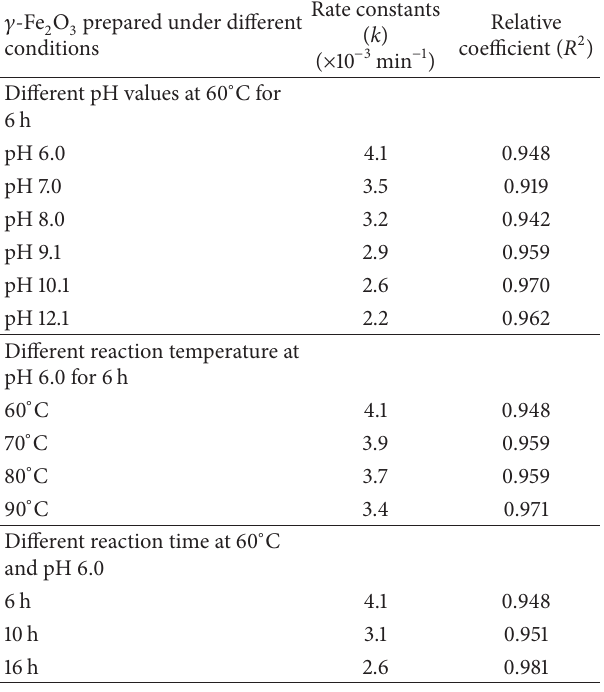
Table 1: Rate constants ( 𝑘 ) of 𝛾 -Fe conditions for Orange I